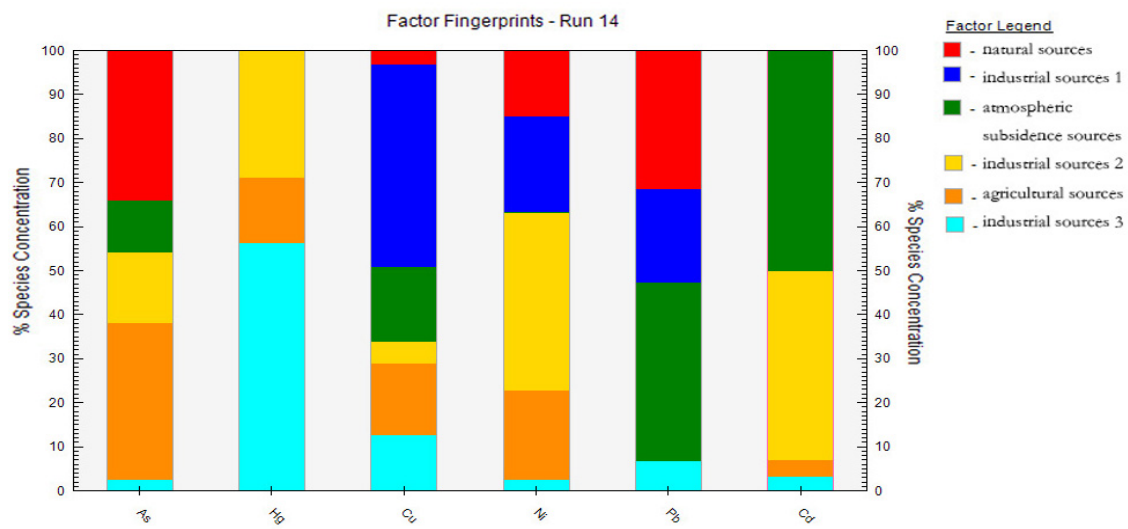
Figure 8: Fingerprint of each element contributing to pollution source